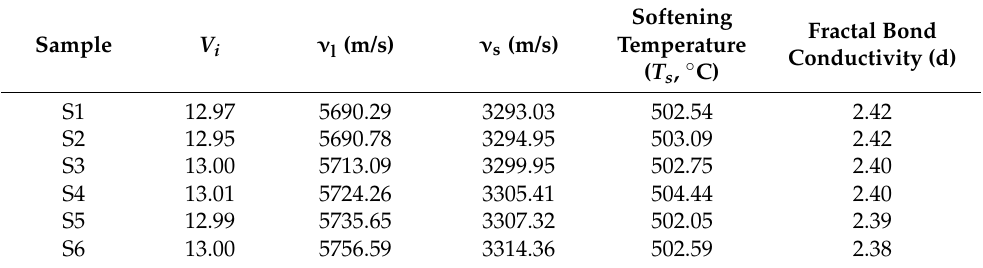
Table 2. Mechanical properties of the investigated glass samples.